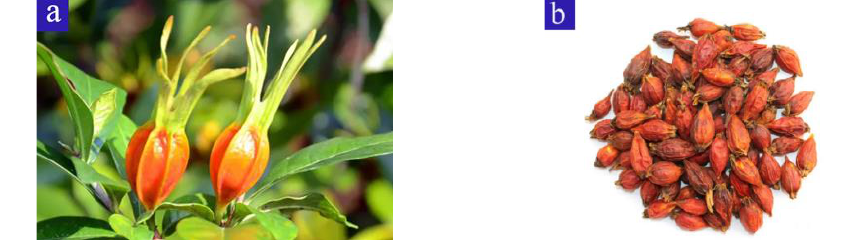
Figure 1. Gardeniae Fructus is the dried ripe fruit of Gardenia jasminoides Ellis. ( a ) Fresh fruit. ( b ) ( b ) Gardeniae Gardeniae Fructus.